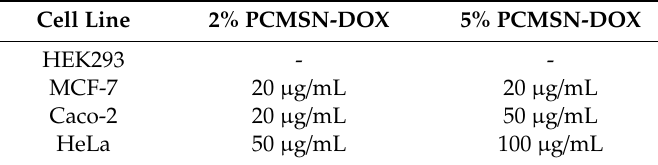
Table 4. IC 50 values of DOX-MSN treatments administered to tested cell lines (from Figure 6).